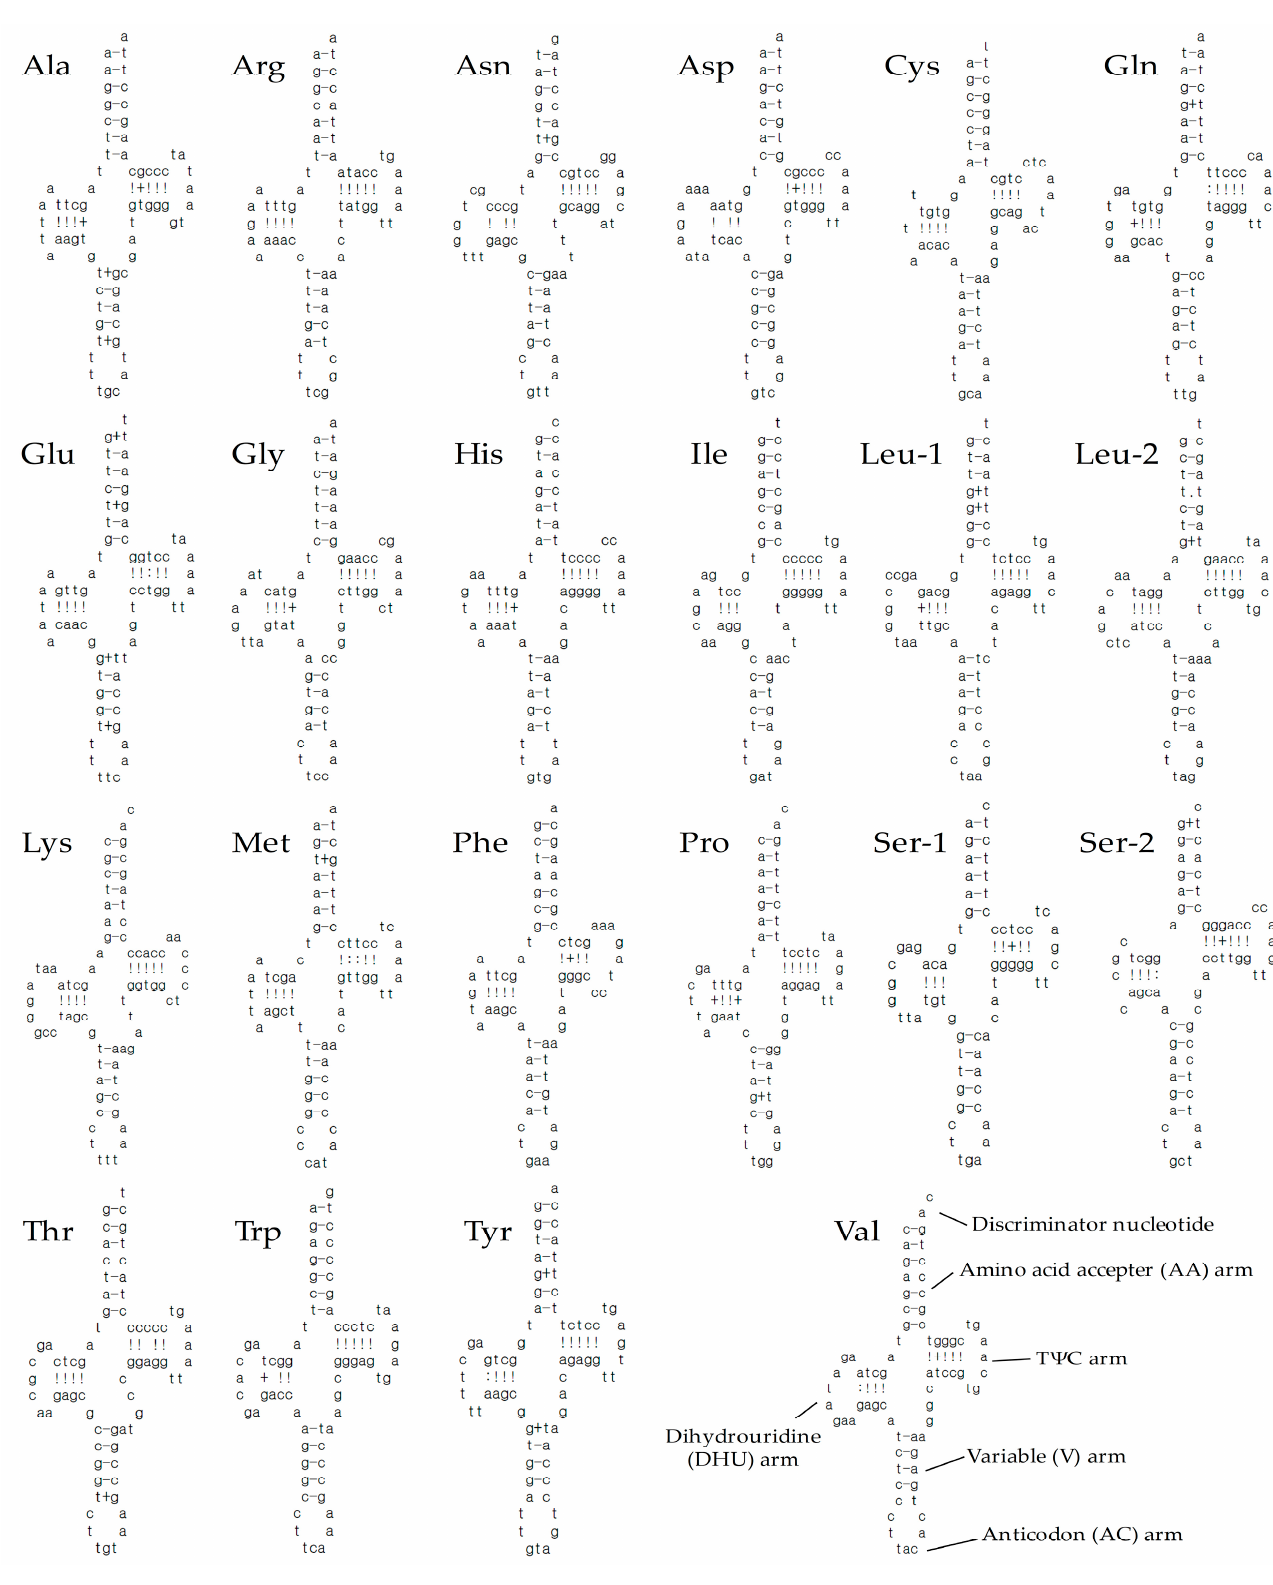
Figure 4. Inferred secondary structures of 23 tRNAs from C. wui .